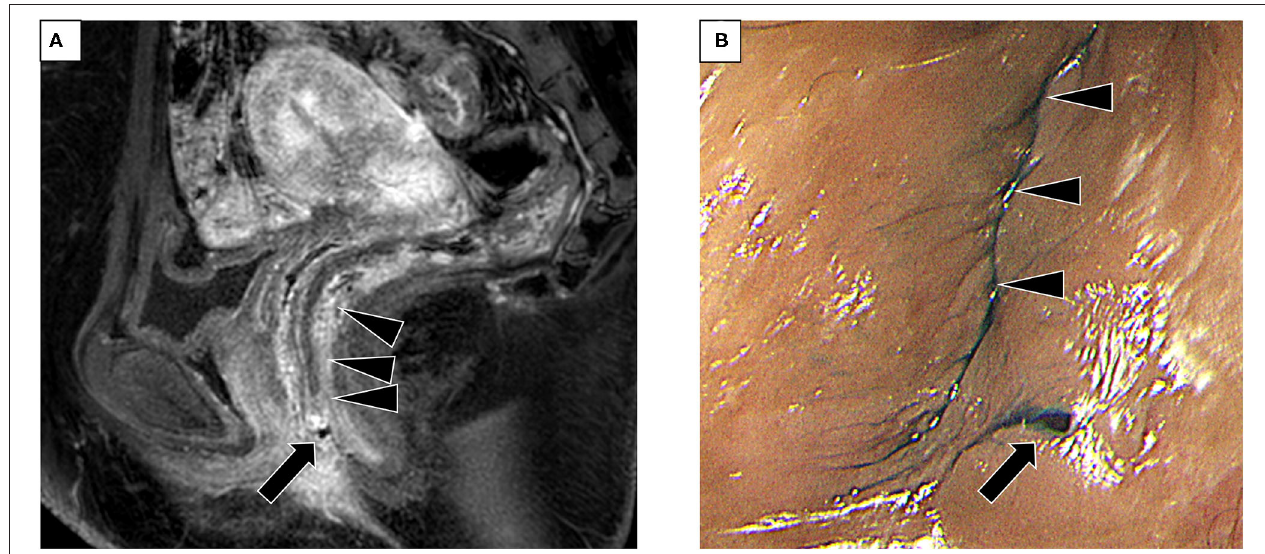
FIGURE 1 | Pre-operative examination for the diagnosis of rectoperineal fistula (A) Magnetic resonance imaging (sagittal view) showing a small tract from the lower rectum. Arrow, small tract. Arrowhead, rectum. (B) Small fistula on the perineal skin visualized after insertion of indigo carmine poured into the rectum (arrow). Arrowhead, vaginal